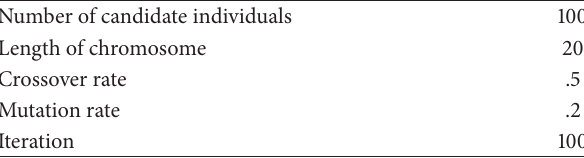
Table 2: GA parameter